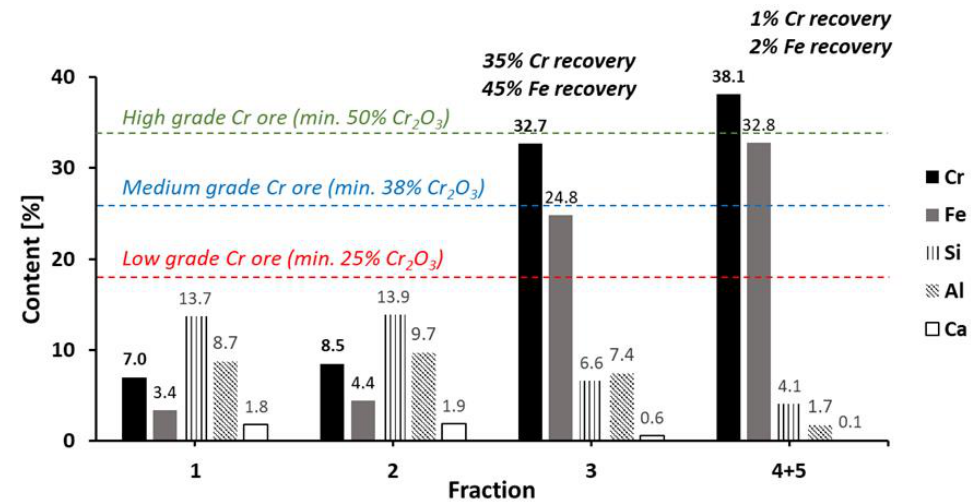
Figure 11. Content of metals in di ff erent fractions after WST (Cr ores grades according to [13]).